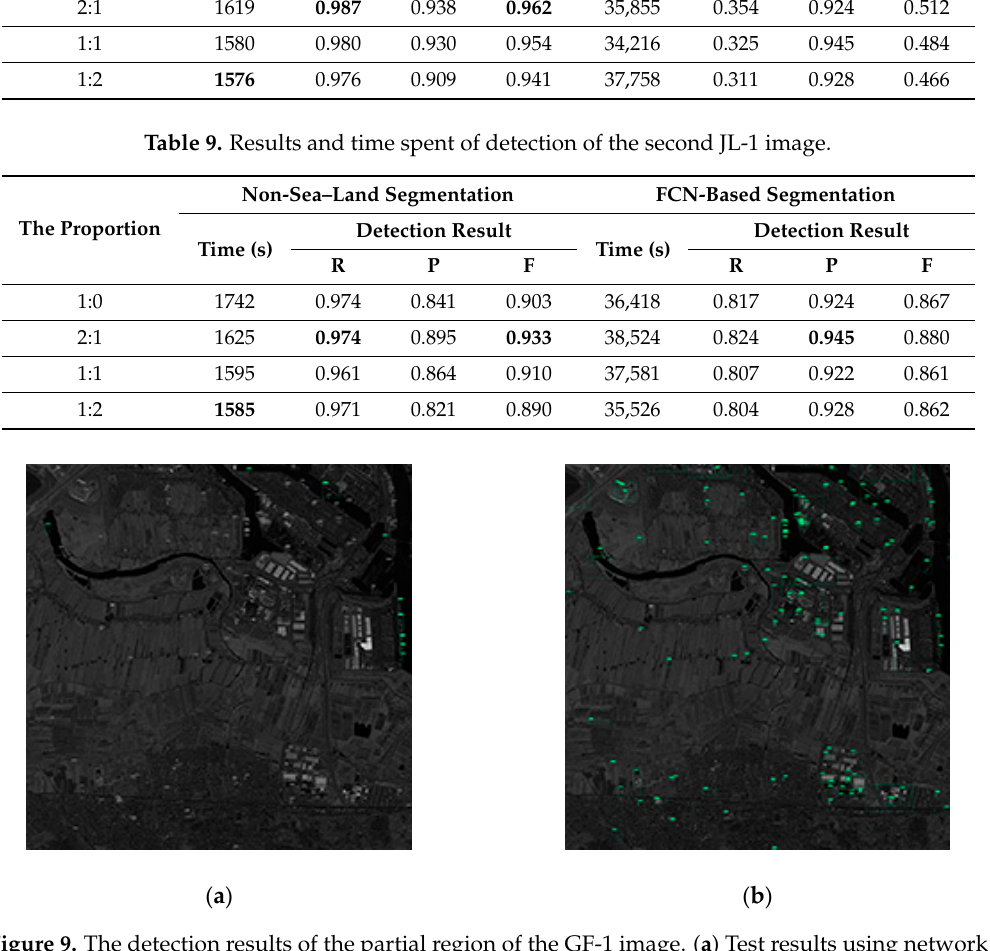
Figure 9. The detection results of the partial region of the GF-1 image. ( a ) Test results using network with a proportion of positive to negative samples of 1:1. ( b ) Test results using network with a proportion of positive to negative samples of 1:0.